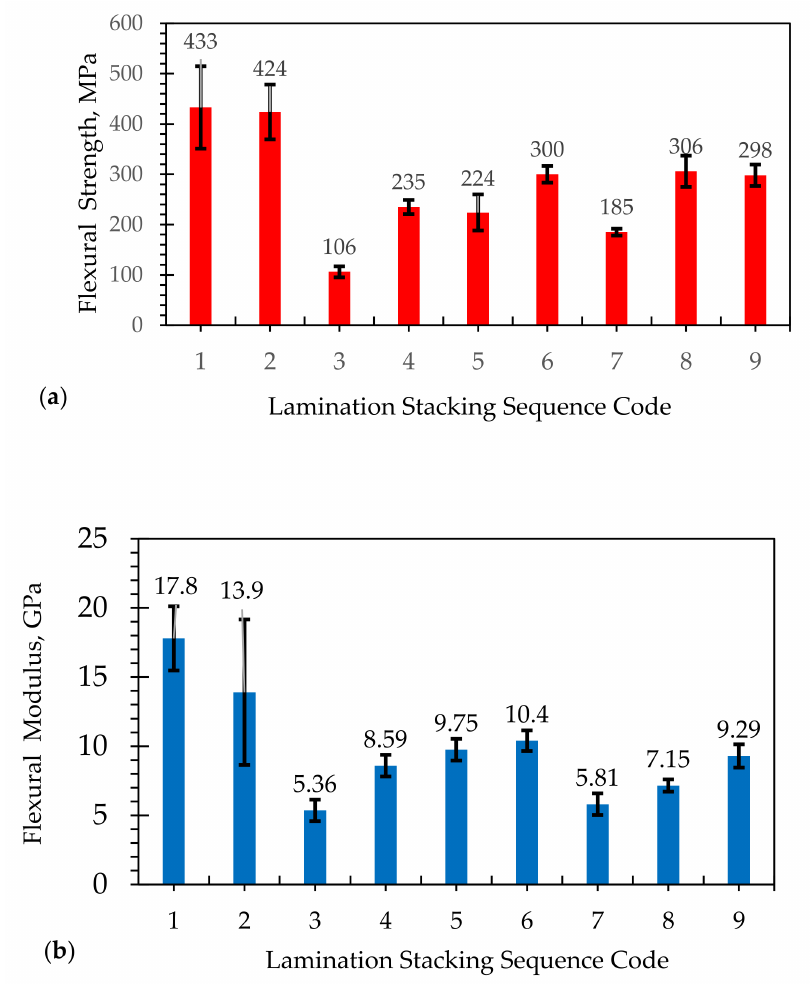
Figure 2. ( a ) Flexural strength and ( b ) flexural modulus of elasticity for different lamination stacking sequences of hybridization of abaca/glass fiber fabricated by VARTM. Note: The numbers 1–9 pertain to lamination stacking sequence code (see Table